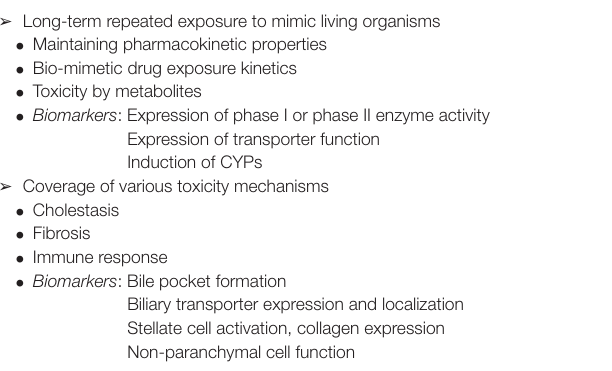
TABLE 2 | Functions required for liver-MPS to evaluate drug-induced liver